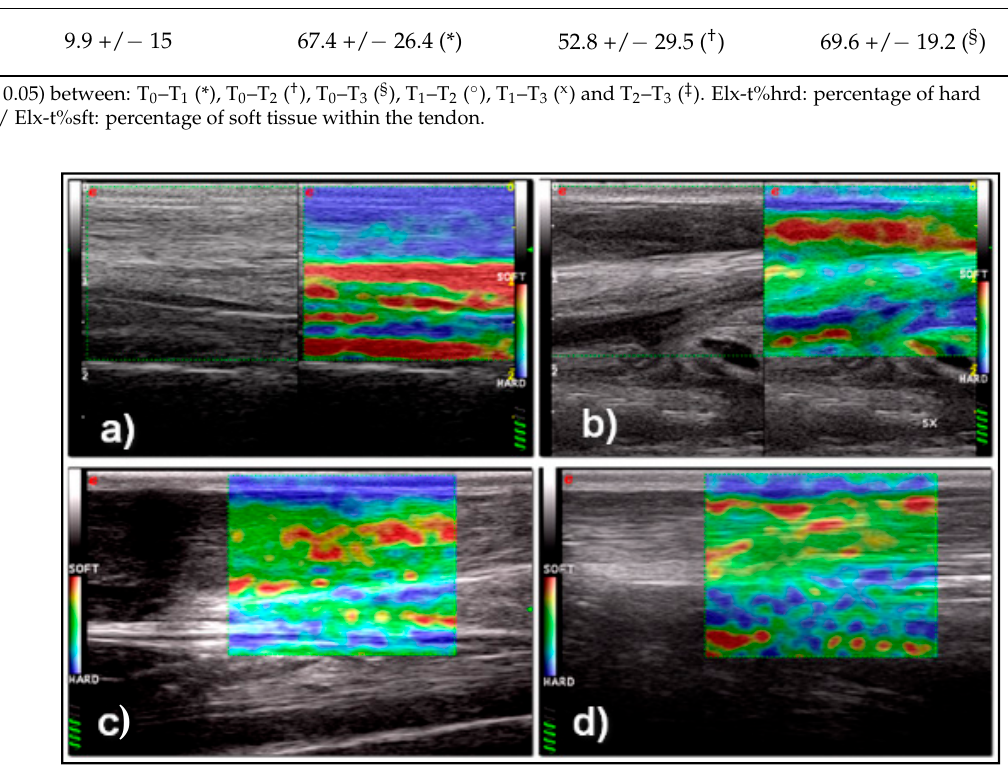
Figure 5. Ultrasonographic and elastosonographic appearance of the normal CCT ( a ): The tendon is homogeneously hard (blue in the color-coded map). Ultrasonographic and elastosonographic appearance of the CCT after 15 days ( b ), 30 days ( c ) and 60 days ( d ) from the induction of the lesion: The tendon is hypoechoic and enlarged with disruption of the normal tendon fibers pattern in all time points. With elastosonography the CCT appears mostly soft (red in color-coded map) after 15 days. After 30 and 60 days the CCT appears of intermediate elasticity (green in color coded map) with areas of softness (red spots on color coded